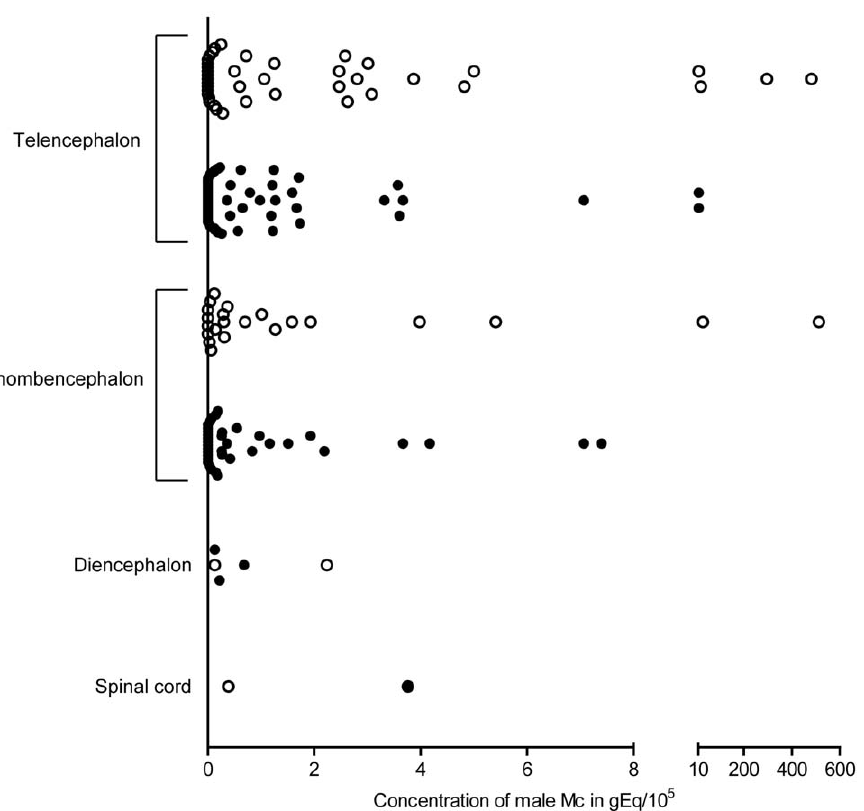
Figure 1. Concentration of male Mc in female human brain regions. Autopsied brain specimens of females without any neurologic disease (open circles) or with AD (filled circles) were tested by qPCR for male DNA. Each point represents one unique brain specimen. Telencephalon consists of neocortical regions (frontal, parietal, temporal, and occipital lobes), limbic regions (hippocampus, amygdala, and cingulate gyrus), and regions of the basal ganglia (putamen, caudate, and globus pallidus). Diencephalon consists of thalamus. Rhombencephalon consists of medulla, pons, and cerebellum. Due to the greater number of data points collected for telencephalon and rhombencephalon, data for each group have been plotted side by side to better present their distributions. Such separation was not done on the data for diencephalon and spinal cord.